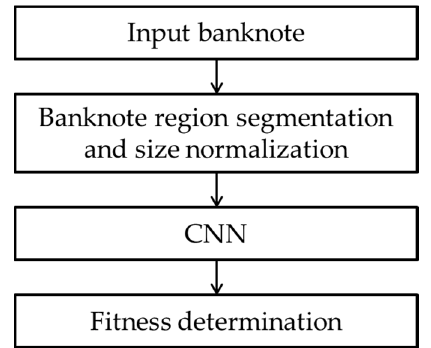
Figure 1. Overall flowchart of the proposed method.